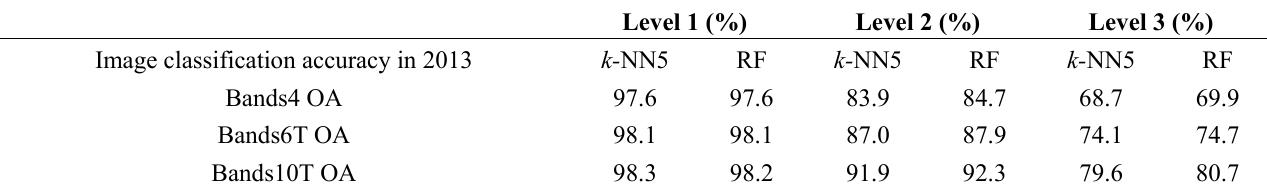
Table 4. The mean value calculated by 10-fold cross validation method for the OA of the three images from Landsat 8 in 2013 with different band combination classified by k-NN and Random Forest: Bands4 represents the image with bands 2 to 5; Bands6T represents the image with bands 2 to 5 and the thermal bands 10 and 11; Bands10T indicates the image with all the 10 bands from Landsat 8 except the panchromatic band; k-NN5 and RF represents the nearest neighbor method with k = 5 and Random Forest, respectively.